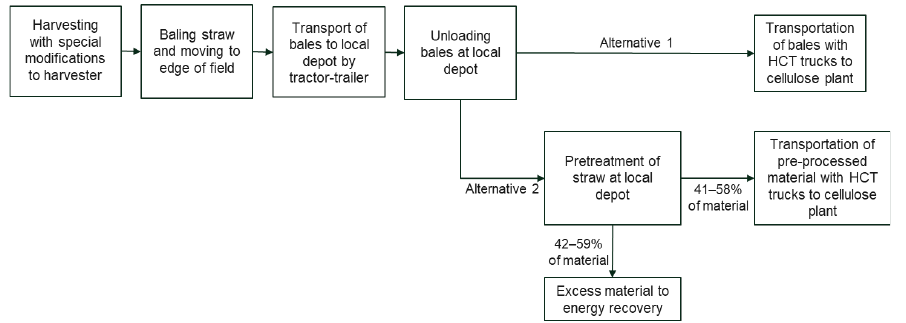
Figure 8. Alternative logistics depend on whether the pretreatment of straw is carried out locally or not before forming the actual